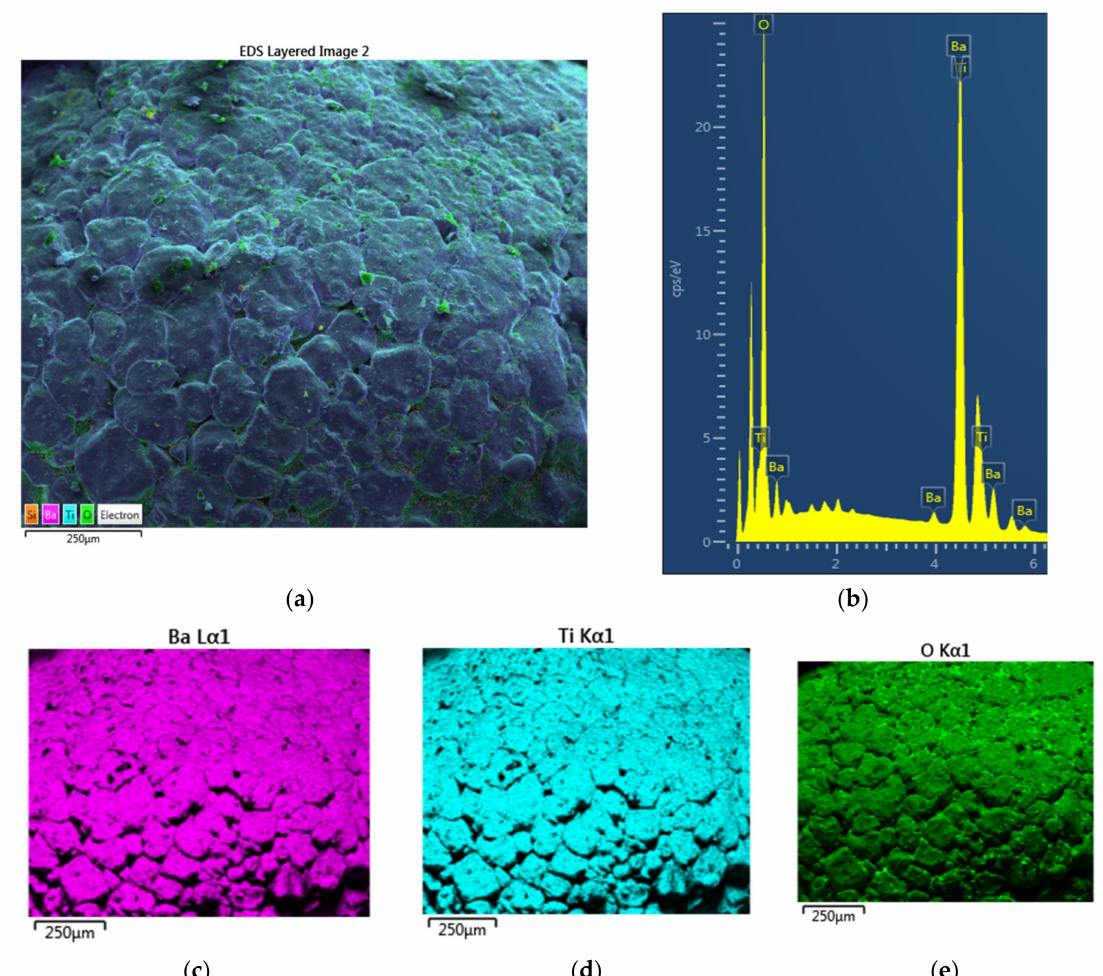
Figure 10. The e ff ect of 10 min microwave irradiation at 1800 W in air with plasma generation on the surface modification of BaTiO 3 particle (Particle-2 in Figure 8). ( a ) EDS layered image; ( b ) EDX-spectra of the area in ( a ) with composition: [O] = 0.676; [N] = 0.00; [Ba] = 0.165; [Ti] = 0.159; ( c ) Ba-mapping; ( d ) Ti-mapping and ( e )